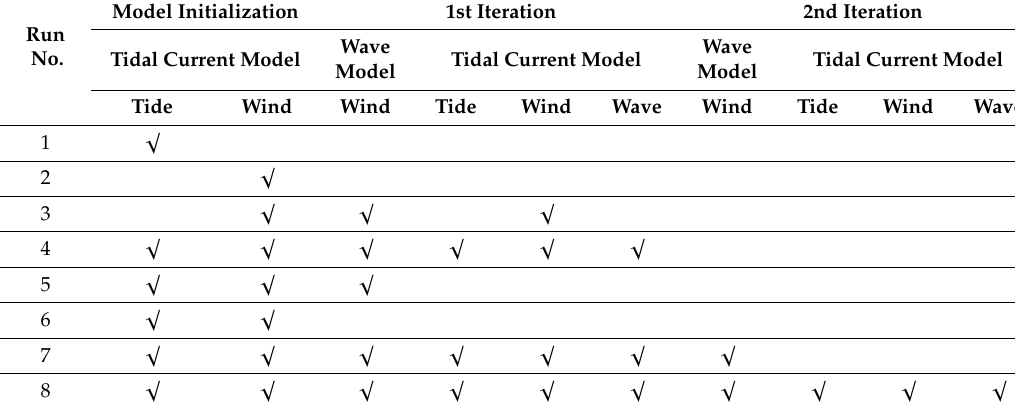
Table 1. Runs of simulations and the setup for sub-models. √ indicates the sub-model and driving force that are considered. The final output of the run comes from the last used sub-model.